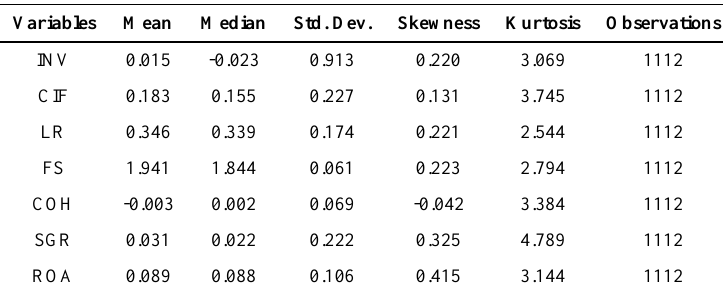
Table 3. Descriptive Analysis.